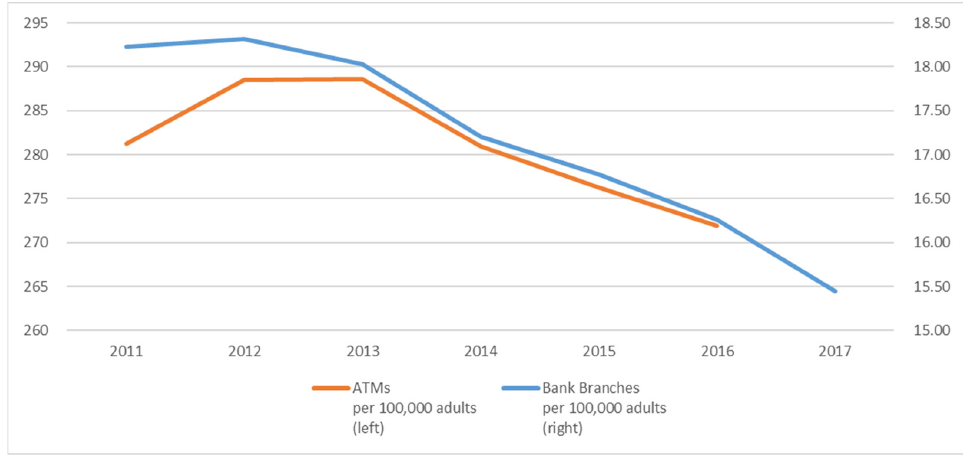
Figure 1. Number of bank branches and ATMs, Korea (2011–2017). Source: (The World Bank 2019).